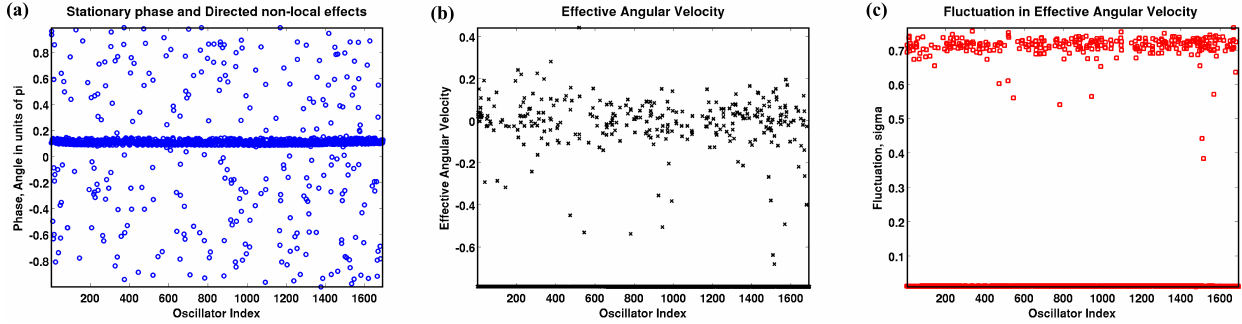
Figure 4. Three attributes of a chimera state of the 1693 oscillators for a 128 × 128 gridded map without recurrences using κ = 0.10.